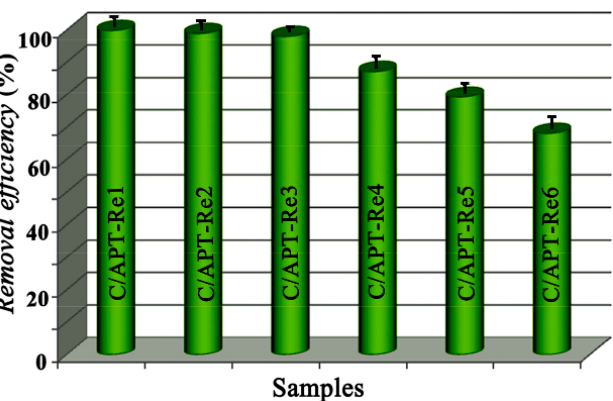
Figure 12. The removal efficiency of the re-generated C/APT-Re adsorbent for MB (dosage of the adsorbents: 2.0 g/L).